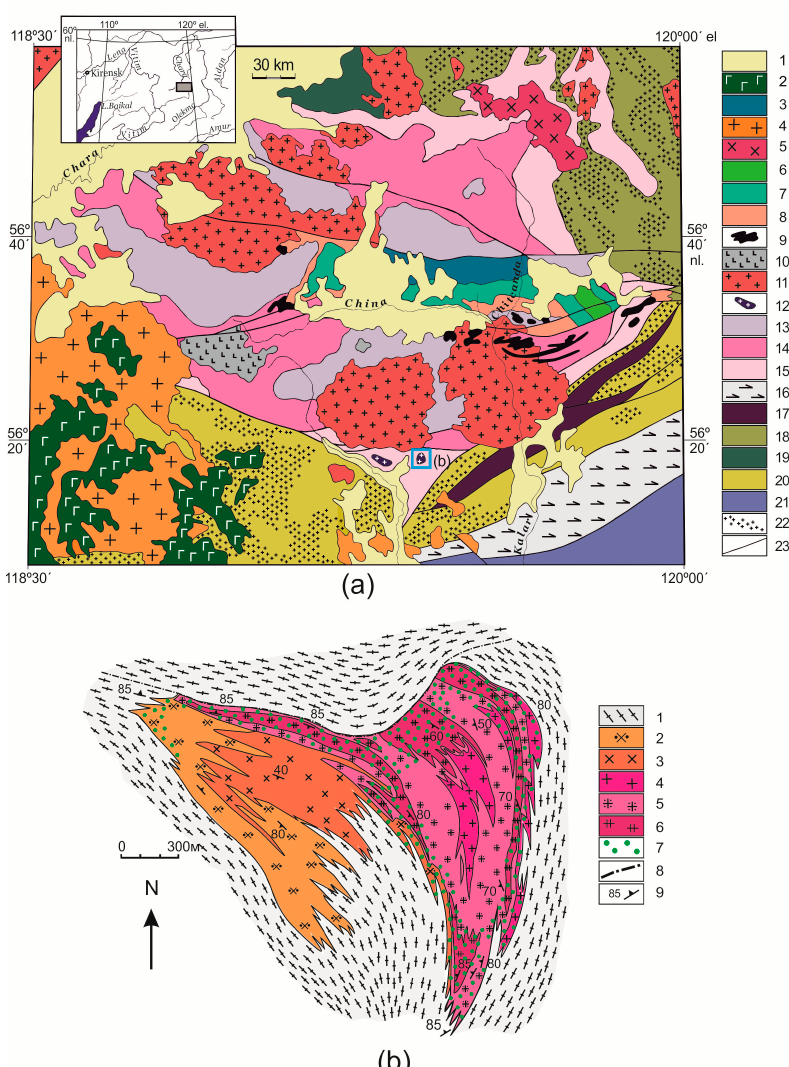
Figure 1. ( а ): Simplified geological map of the region of the Katugin granite complex, after [22,31]. 1 = Quaternary sediments; 2 = flood basalts (N 2 -Q); 3 = Jurassic coal-bearing clastic sediments; 4 = granite, granodiorite, granosyenite and monzonite of the Ingamakit complex (PZ 3 ); 5 = nepheline syenite, granosyenite and monzonite of the Khanin complex (PZ 3 ); 6 = Ordovician variegated sediments; 7 = Cambrian variegated sediments; 8 = Vendian variegated sediments; 9 = gabbro-dolerite, gabbro and dolerite porphyrite of the Doros complex; 10 = layered plutons of the Chinei complex; 11 = granite of the Kodar complex; 12 = rare-metal granite of the Katugin complex; 13–15 = carbonate and clastic sediments of the Udokan supergroup: Kemen group (13), Chinei group (14), and Kodar group (15); 16 = anorthosite of the Kalar complex; 17 = low-grade metamorphic volcanic-sedimentary rocks of the Subgan complex; 18 = tonalite-trondjemite orthogneis of the Olekma complex; 19 = Chara sequence (garnet-biotite and garnet-hypersthene-biotite plagiogneiss, mafic schists, quartzite and magnetite quartzite); 20 = Kalar sequence (garnet-biotite plagiogneiss with layers and lenses of two-pyroxene mafic granulite, clac-silicate rocks, quartzite, and magnetite quartzite; 21 = metamorphic and igneous complexes of the Selenga-Stanovik superterrane in the Central Asian orogenic belt; 22 = zones of widespread Precambrian granitic rocks; 23 = faults. ( b ): Simplified geology of the Katugin granite intrusion, after [21,32]. 1 = gneiss, migmatite, blastomylonite of the Kodar group, Udokan group; 2–6 = Katugin granites of different types: biotite (2), biotite-riebeckite (3), biotite-arfvedsonite (4), arfvedsonite (5), aegirine-arfvedsonite and aegirine (6); 7 = ore-bearing granite; 8 = faults; 9 = bedding elements.